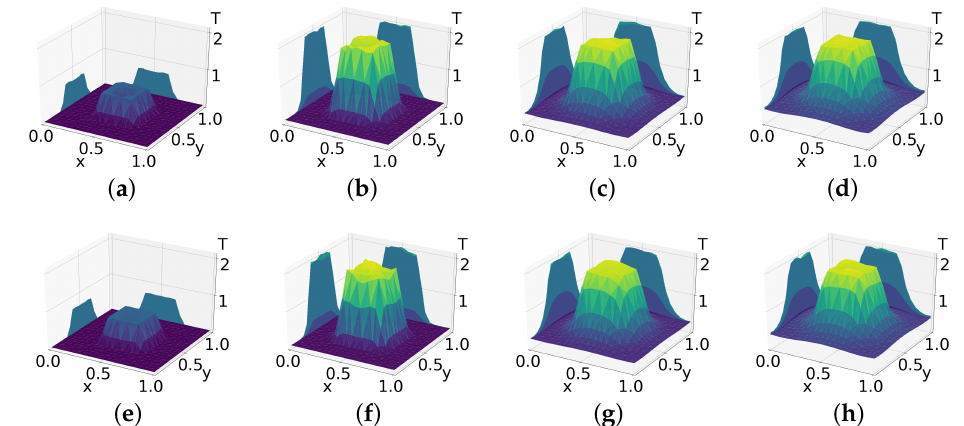
( t , x ) , ξ , t , x )] on the first prediction horizon by Figure 7. Mean temperature realizations E [ T ∗ ( u ∗ ( 0, H ] τ = 5 × 10 − 5 ; ( a ) OA , t = 0.025; ( b ) OA , t = 0.2; ( c ) OA , t = 1.0; ( d ) OA , t = 2.0; ( e ) IA , t = 0.025; ( f ) IA , t = 0.2; ( g ) IA , t = 1.0; ( h ) IA , t = 2.0.